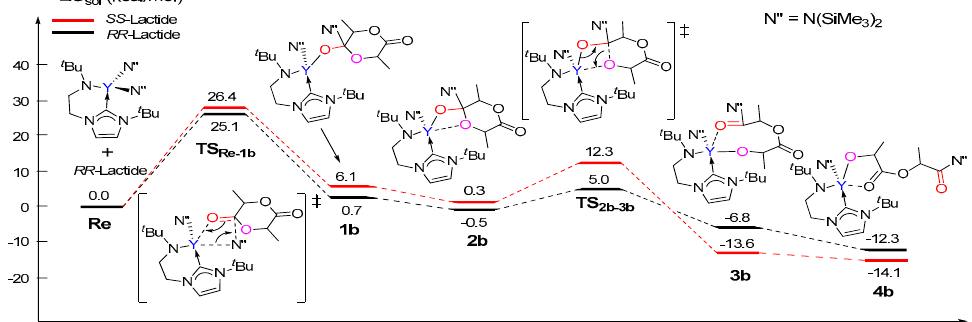
Figure 2. Calculated free energy profile for the chain initiation of the ROP of rac -lactide along path B. TS Re-1b , nucleophilic addition transition state; TS 2b-3b , ring-opening transition state.